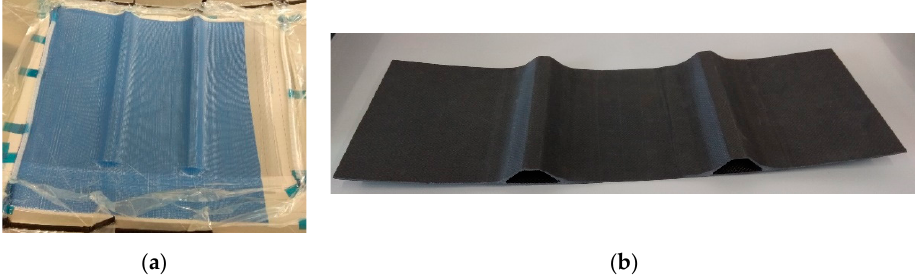
Figure 1. Considered composite panel: ( a ) manufacturing process and ( b ) final effect.